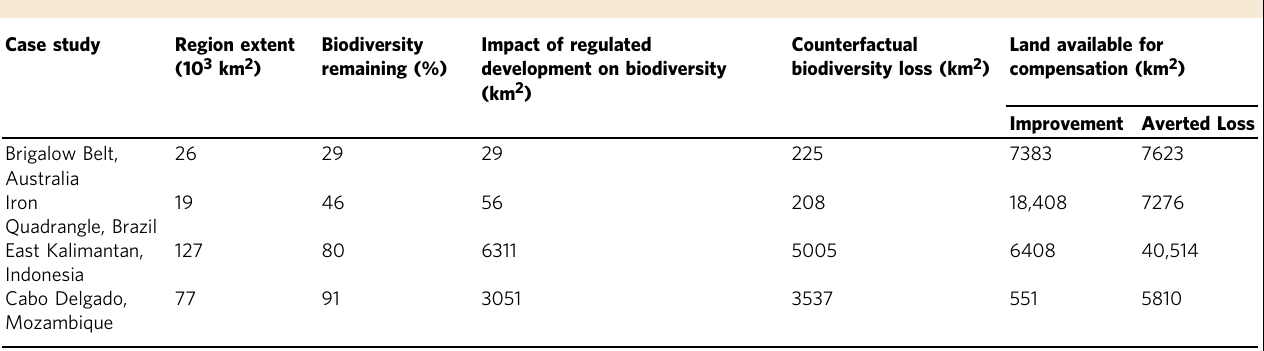
Table 1 Differences in local conditions across case studies.